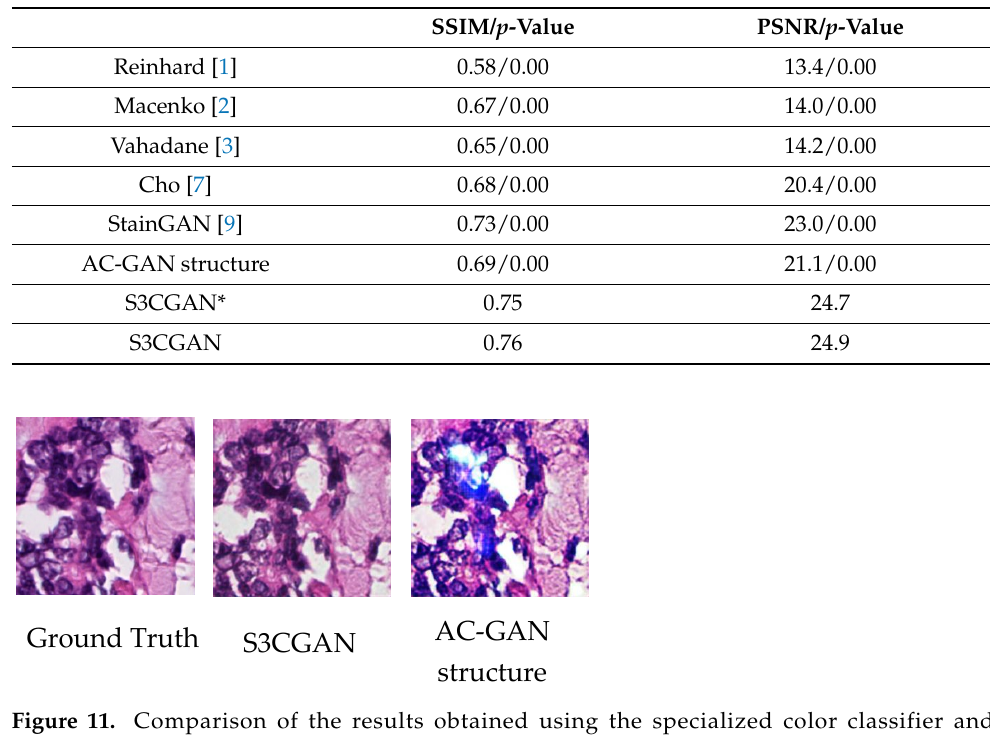
Table 2. Mean SSIM and mean PSNR values for different stain transfer methods.